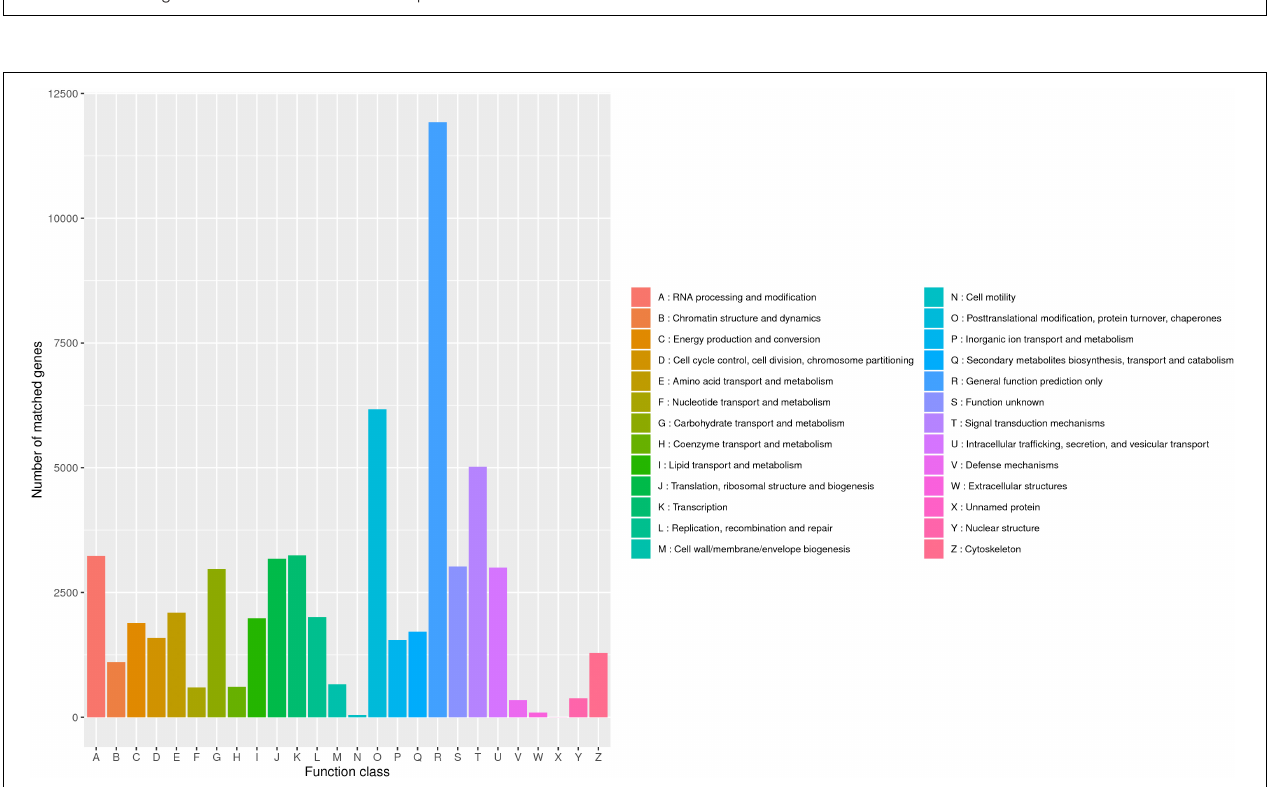
FIGURE 3 | The distribution of CDS and TF. (A) CDS length distribution map of B. striata transcriptional group: Abscissa is the predicted length of CDS; ordinate is the number of transcripts of CDS. (B) TF analysis: B. striata transcriptional group TF analysis predicted that the above picture shows the top 30 transcription factor families with the largest number of annotated transcripts.